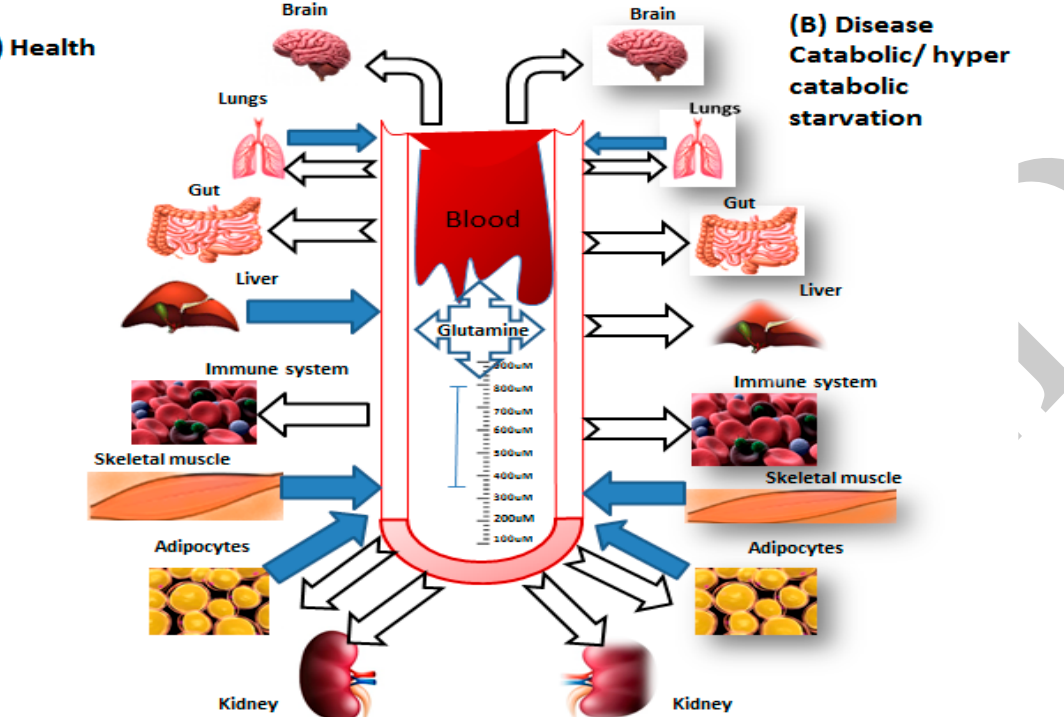
Figure 2. Glutamine production and utilization inside the tissue in health and disease conditions. The blue arrows designate tissue that shows the activity of GS and thus, the synthesis of glutamine; The white arrows designate tissue that shows the activity of GS and thus, the utilization of glutamine. In healthy or in fed conditions, glutamine stocks are equal in plasma and tissues and are sustained mostly by the liver and skeletal muscles. There are two major sites for the storage of glutamine in the body. Alternatively, immune cells enormously depend on glucose and glutamine in condition ( A ), and more in condition ( B ). While the GIT is a principal place for the utilization of the glutamine in condition ( B ), glutamine utilization from both the basolateral and luminal membranes is increased when compared to condition ( A ). Furthermore, the liver changes its role from chief glutamine producer to chief glutamine consumer to sustain gluconeogenesis and the entire body depends on the skeletal muscle’s ability to sustain the glutamine concentrations. The current reaction is typically accompanied by a dramatic upsurge proteolysis of muscle, cachexia, and atrophy. The adipose tissue and lungs exhibit enzymes GS and GLS, and hence, can synthesize and utilize glutamine in conditions ( A , B ). The kidneys and brain do not exhibit GS, only GLS, and hence, are mostly reliant on the availability of plasma glutamine in conditions ( A , B ).